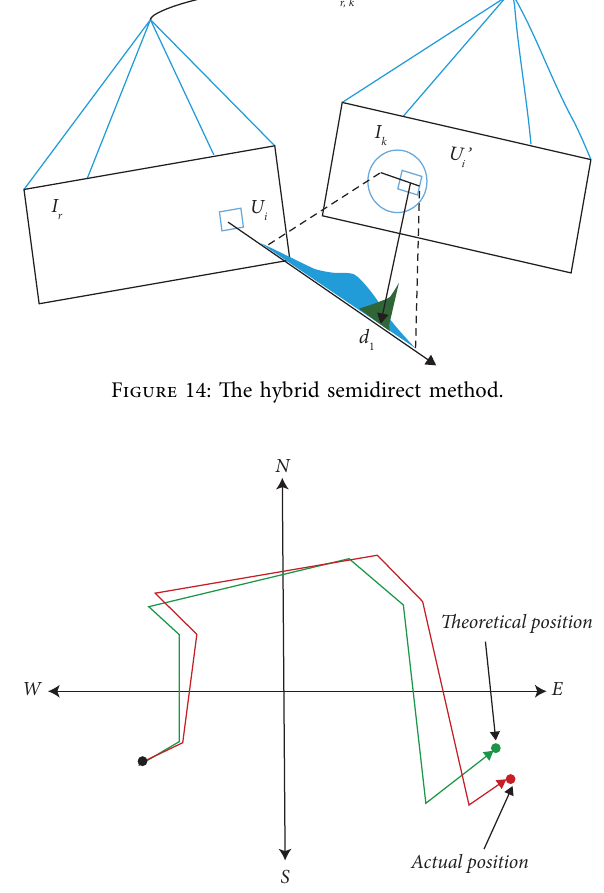
Figure 15: Cumulative